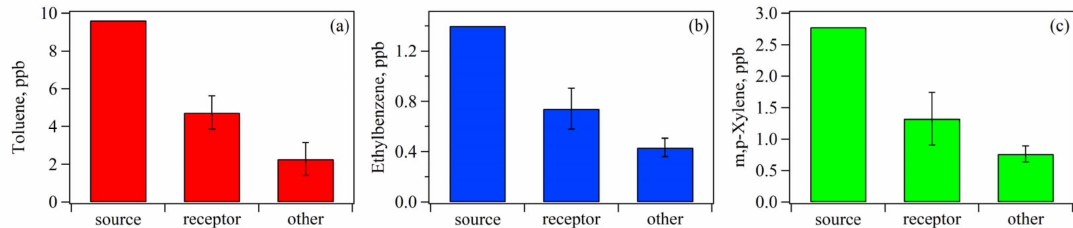
Figure 5. Comparison of average mixing ratios for ( a ) toluene, ( b ) ethylbenzene, and ( c ) m,p -xylene measured at the source, receptor, and other